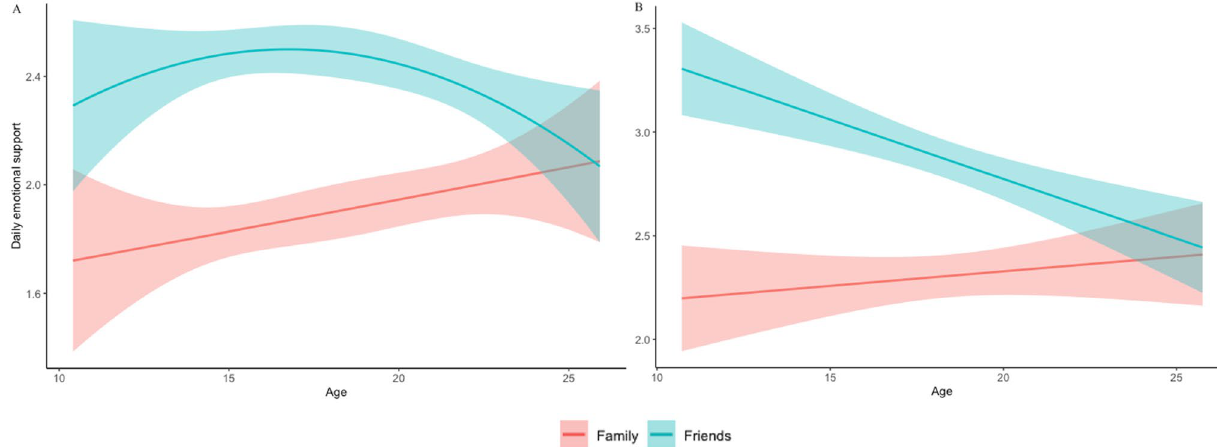
Figure 3. Mean levels of daily emotional support toward friends and family members in May 2020 at T1 ( A ) and in November 2020 at T2 ( B ) during the COVID-19 pandemic. At T1, adolescents displayed higher levels of emotional support to friends compared to family, and this difference was especially pronounced in late adolescence. At T2, adolescents again showed higher levels of emotional support to friends compared to family, with a linear decrease in emotional support to friends with age. Band widths indicate 95% confidence intervals. Note that the y-axis is scaled per time point.